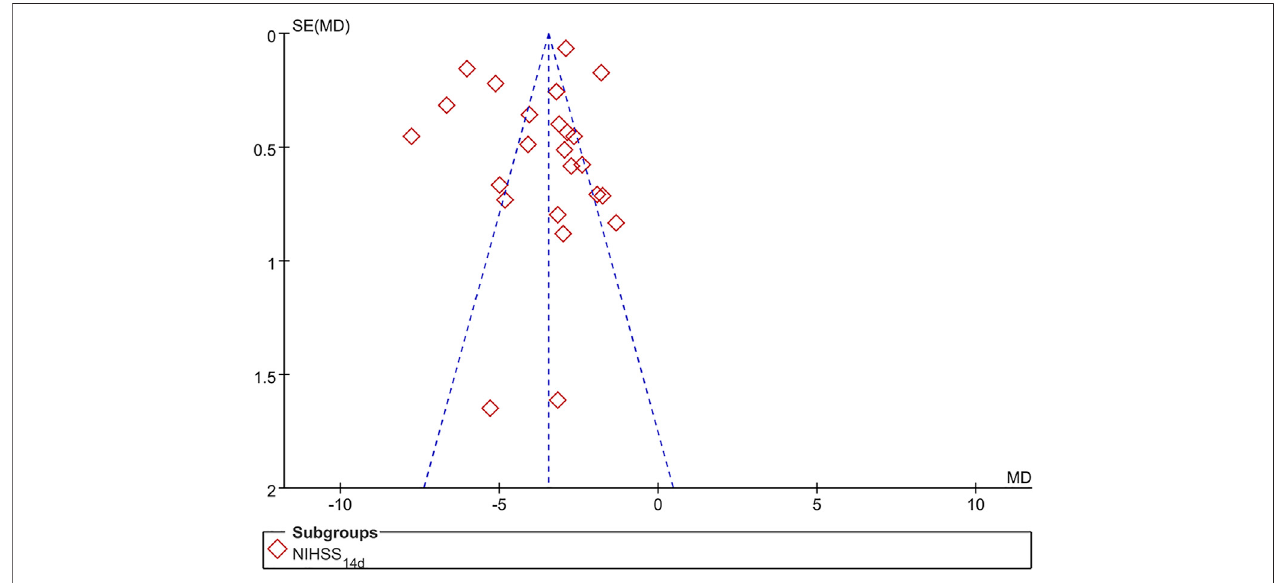
FIGURE 11 | Funnel plot of NIHSS at 14